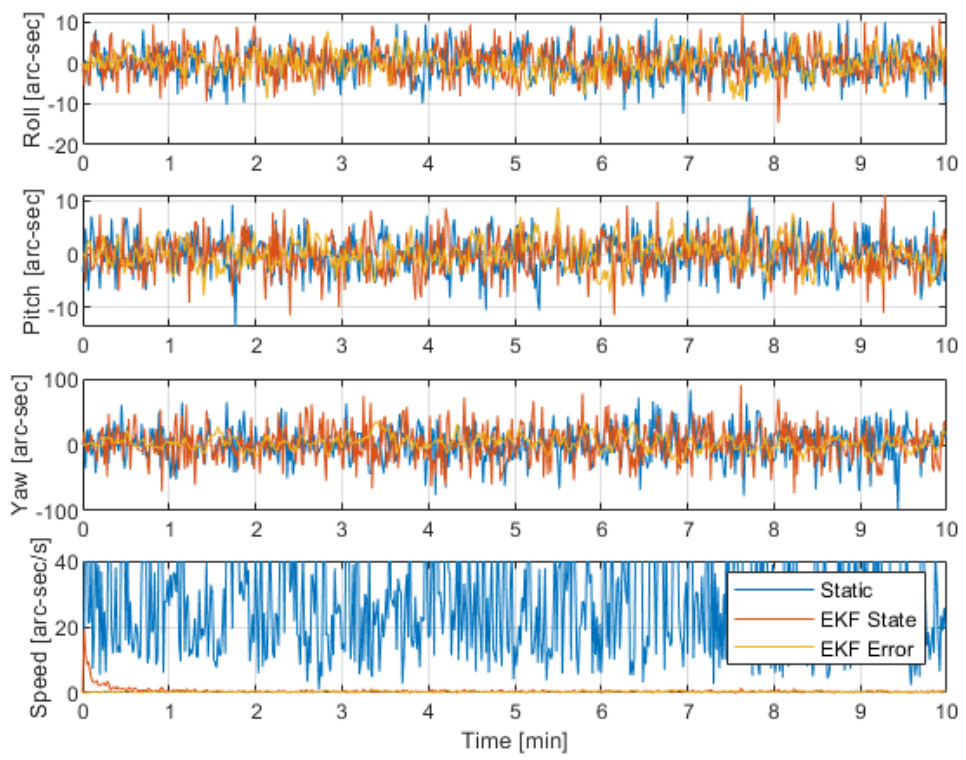
Figure 2. Attitude measurement performance for the simulation operating at a constant speed of 36